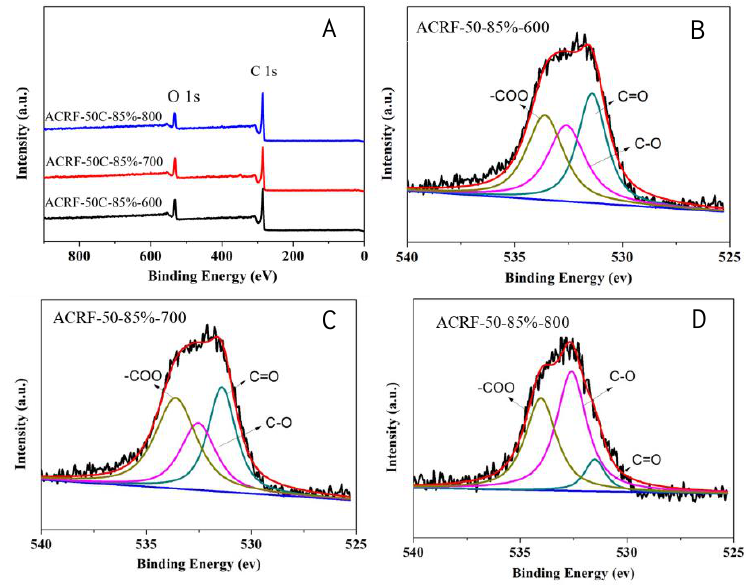
Figure 2. X-ray photoelectron spectroscopy (XPS) spectra of all ACRFs ( A ) and deconvolution of O 1s peaks of ACRF-50-85%-600 ( B ), ACRF-50-85%-700 ( C ) and ACRF-50-85%-800 ( D ). When the temperature is over 700 ◦